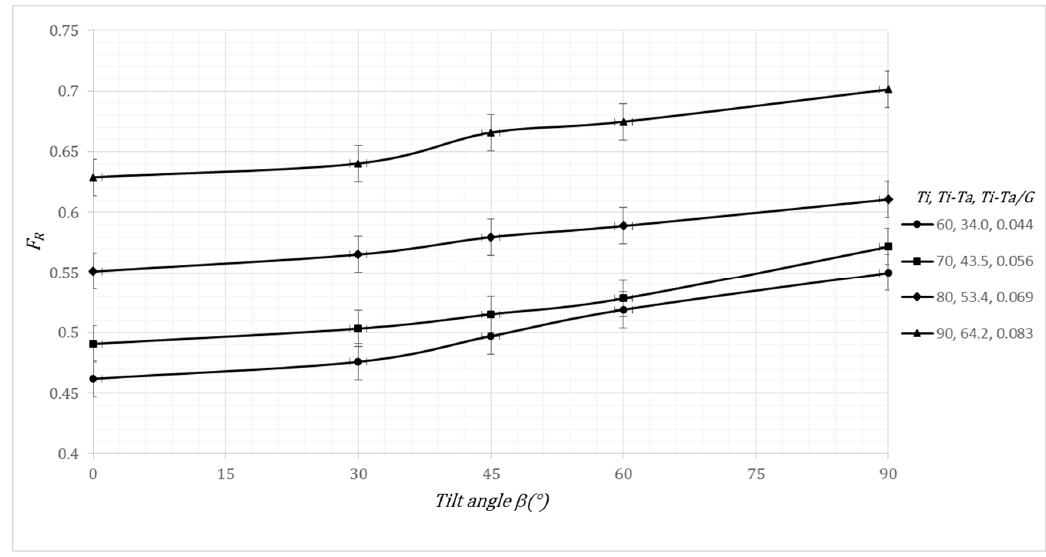
Figure 8. F R vs. β and ( Ti − Ta )/ G by Method 1.